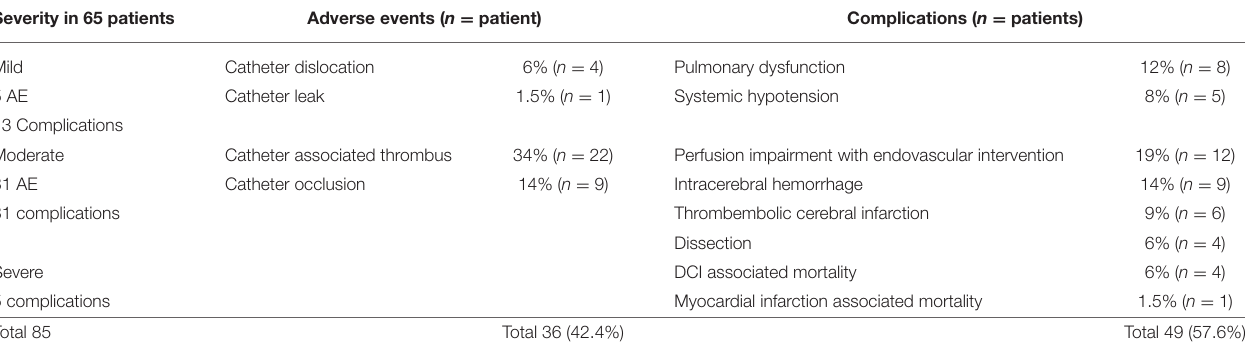
TABLE 3 | Adverse events and complications in context of continuous intra-arterial nimodipine infusion. Severity in 65 patients